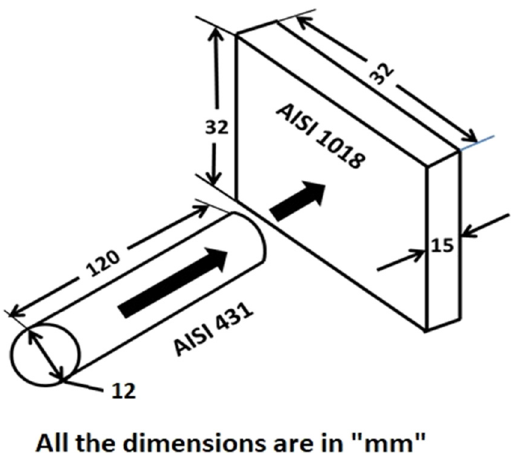
Figure 3: Dimensions of rod - to - plate joint con fi guration.